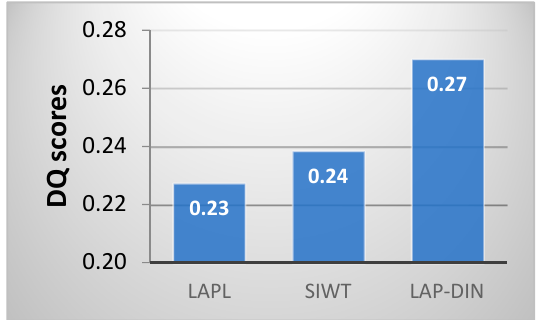
Figure 13. DQ fusion performance scores. Table 1. Fusion performance scores for individual sequences.